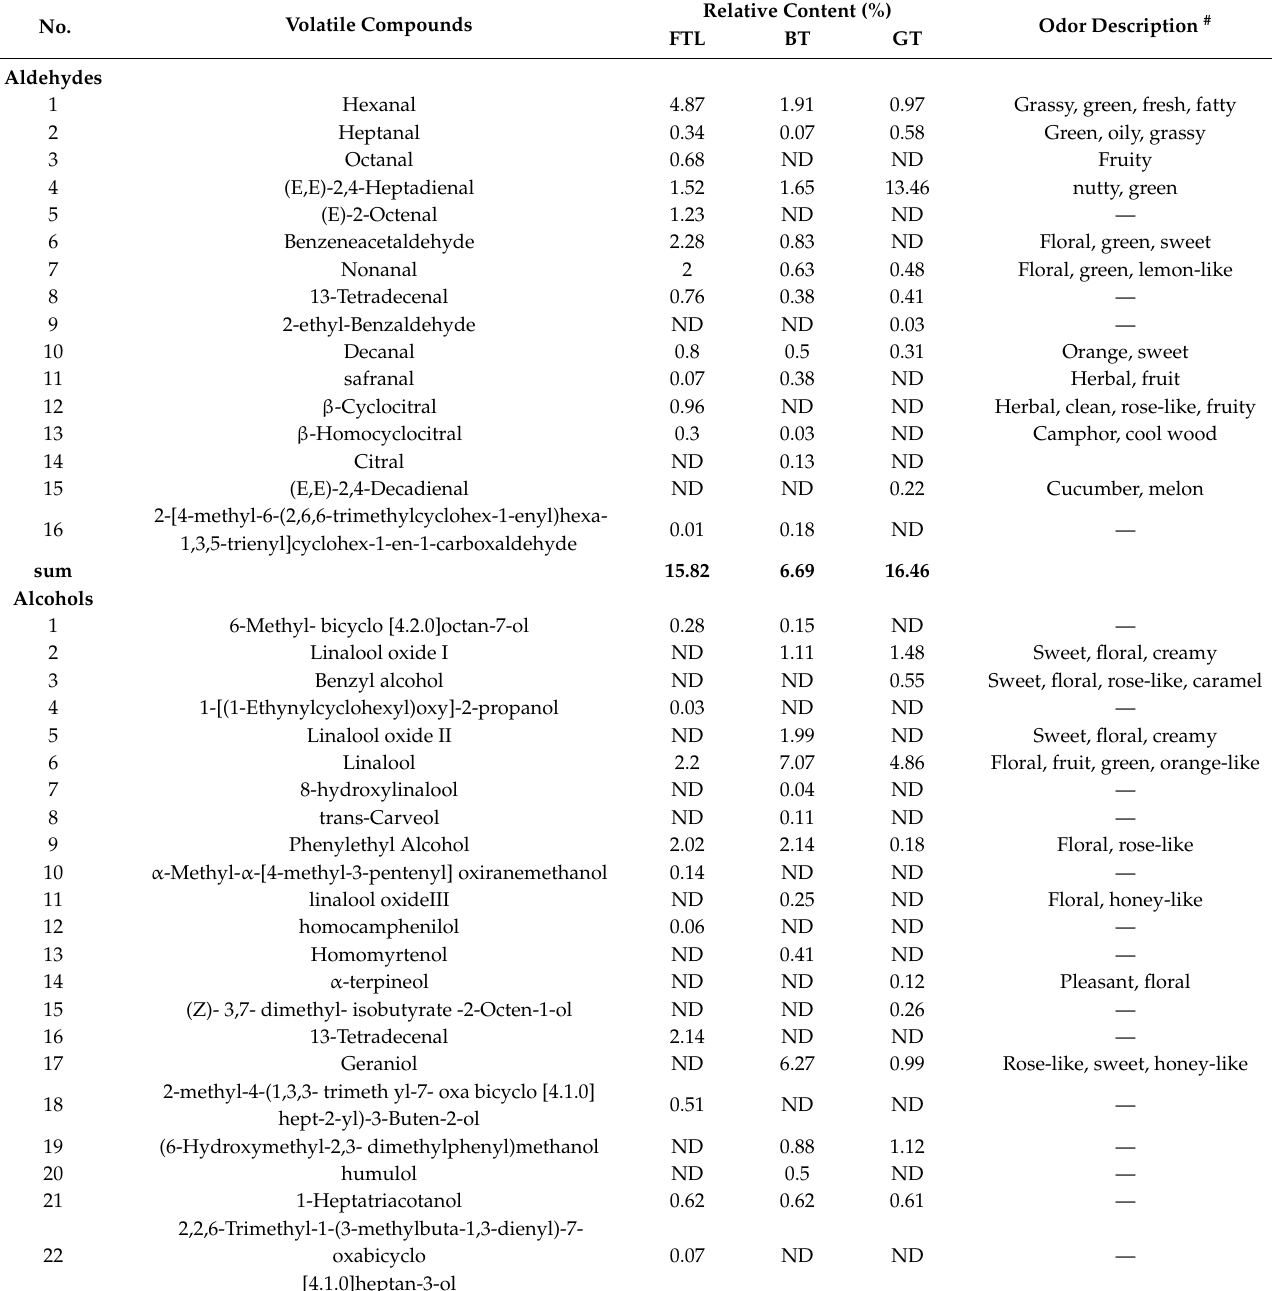
Table 2. Volatile compounds identified in different teas by